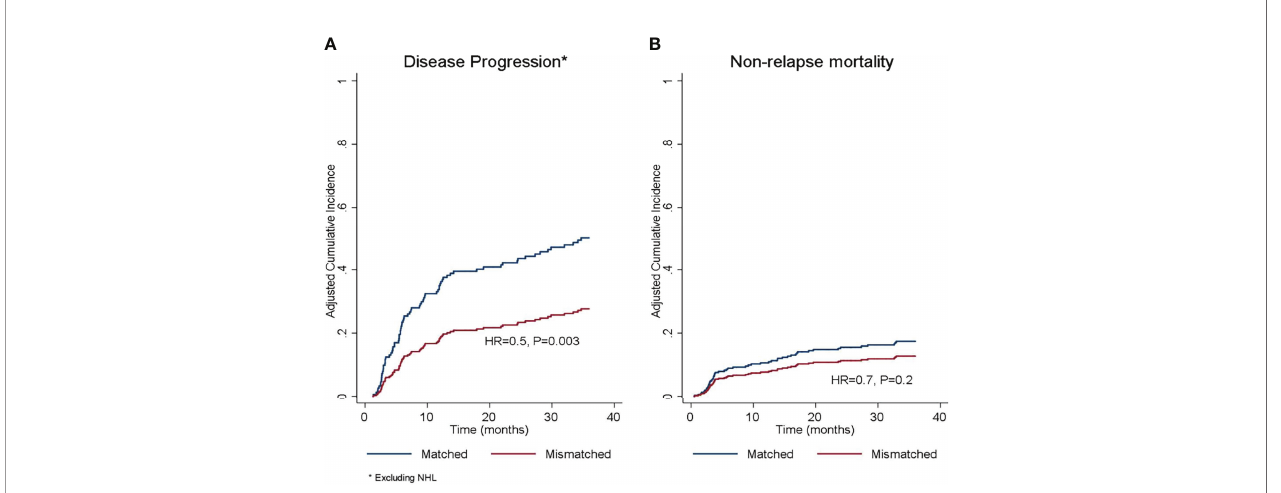
FIGURE 2 | Adjusted cumulative incidence of (A) disease progression and (B) non-relapse mortality according to donor/recipient SIRP a match or mismatch status. HR, hazard ratio. *The protective effect of SIRP a mismatch was limited to diagnoses other than non-Hodgkin ’ s